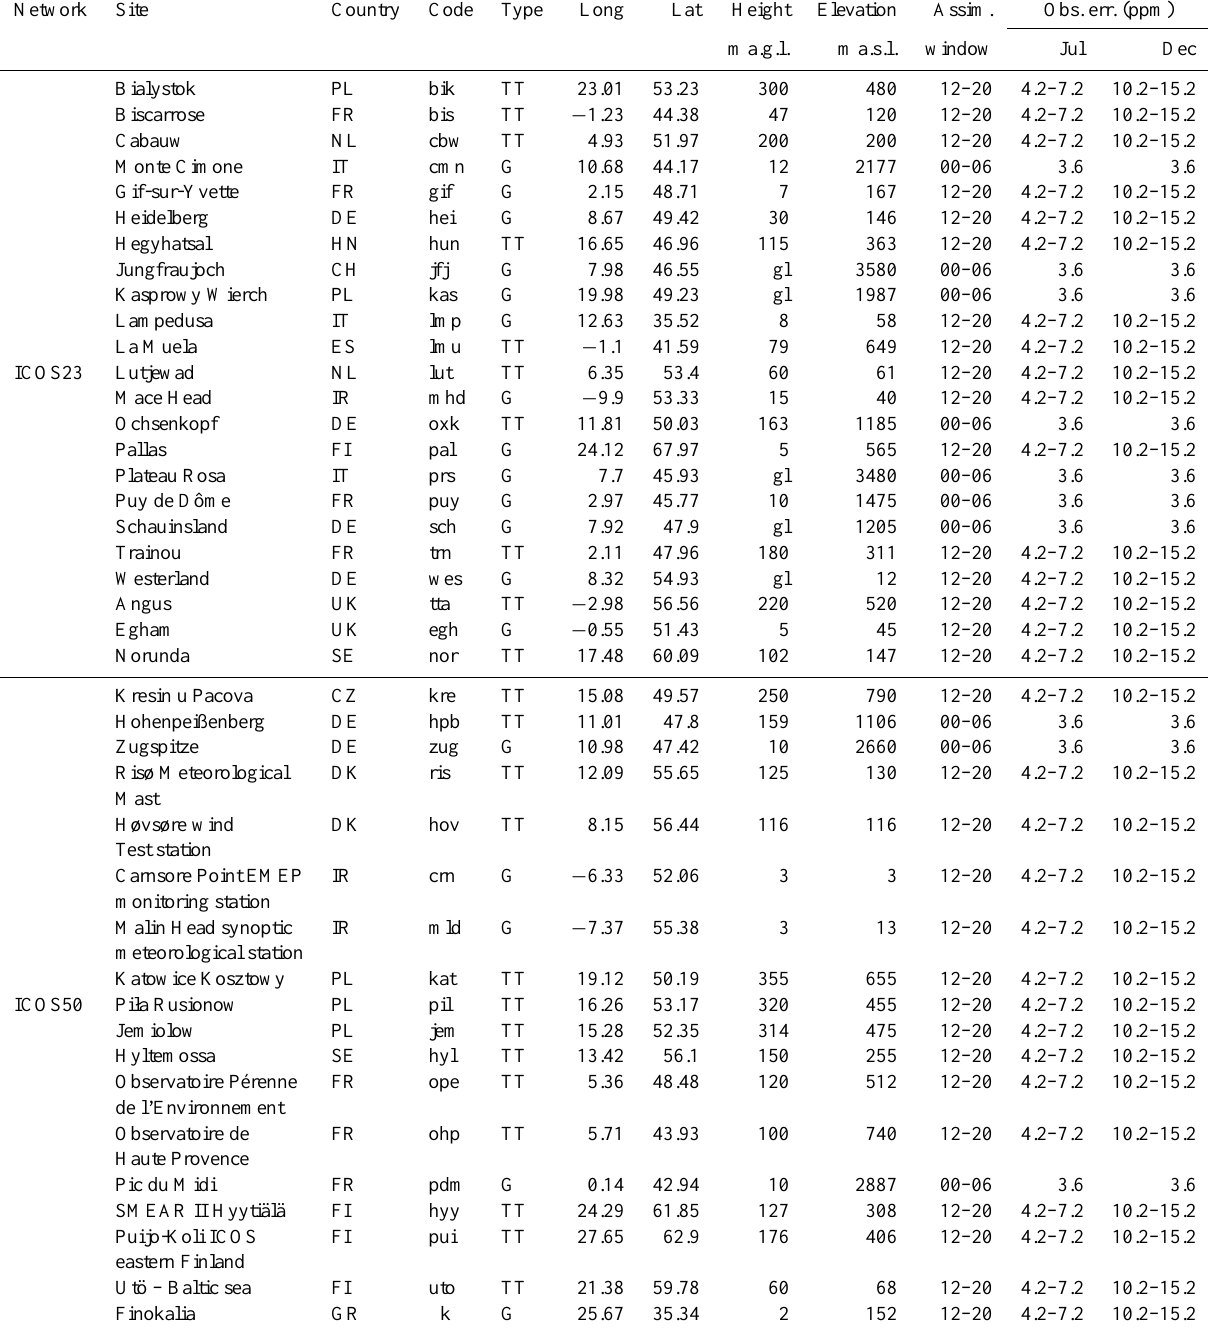
Table A1. Atmospheric measurement sites for the different ICOS network configurations considered in this study with associated observation errors in the reference configuration of the inversion. Two values are given for the observation error at a given site for low altitude sites: that for temporal window 12:00–18:00 (left) and temporal window 18:00–20:00 (right), and one value for temporal window 00:00–06:00 at high altitude sites. Type column represents the way of the station installation: on ground sites (G) or on tall towers (TT). Height corresponds to the vertical location of the site above the ground level (ma.g.l.) and elevation corresponds to its vertical location above sea level